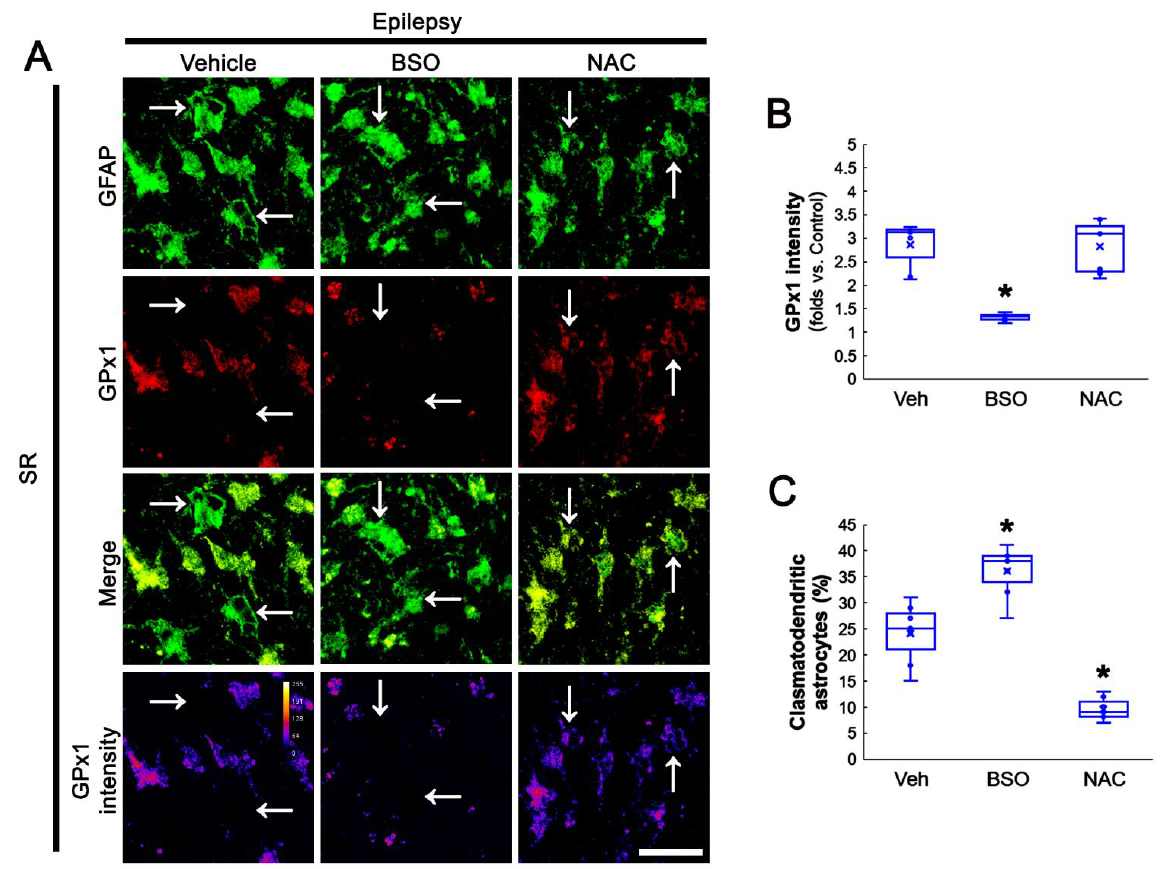
Figure 7. Effects of BSO and NAC on GPx1 expression in the stratum radiatum (SR) of the CA1 region of chronic epilepsy rats. As compared to vehicle (Veh), BSO diminishes GPx1 expression and exacerbates clasmatodendrosis of CA1 astrocytes (arrows). NAC does not affect GPx1 intensity in CA1 astrocytes, but ameliorates this autophagic astroglial degeneration with increased GPx1 intensity in vacuolized astrocytes. ( A ) Representative photos of GPx1 expression and its intensity. Bar = 25 µ m. ( B , C ) Quantification of GPx1 ( B ) intensity and clasmatodendritic degeneration ( C ) in CA1 astrocytes (* p < 0.05 vs. vehicle, n = 7, respectively).